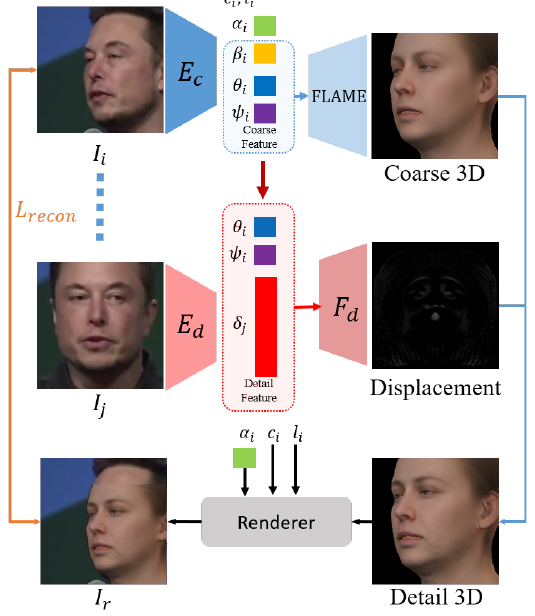
Figure 3. Illustration of our 3D detail extractor’s training process. E c is the state-of-the-art 3D reconstruction model which disentangles the input face. The disentangled face parameters are then recombined into coarse feature and detail feature